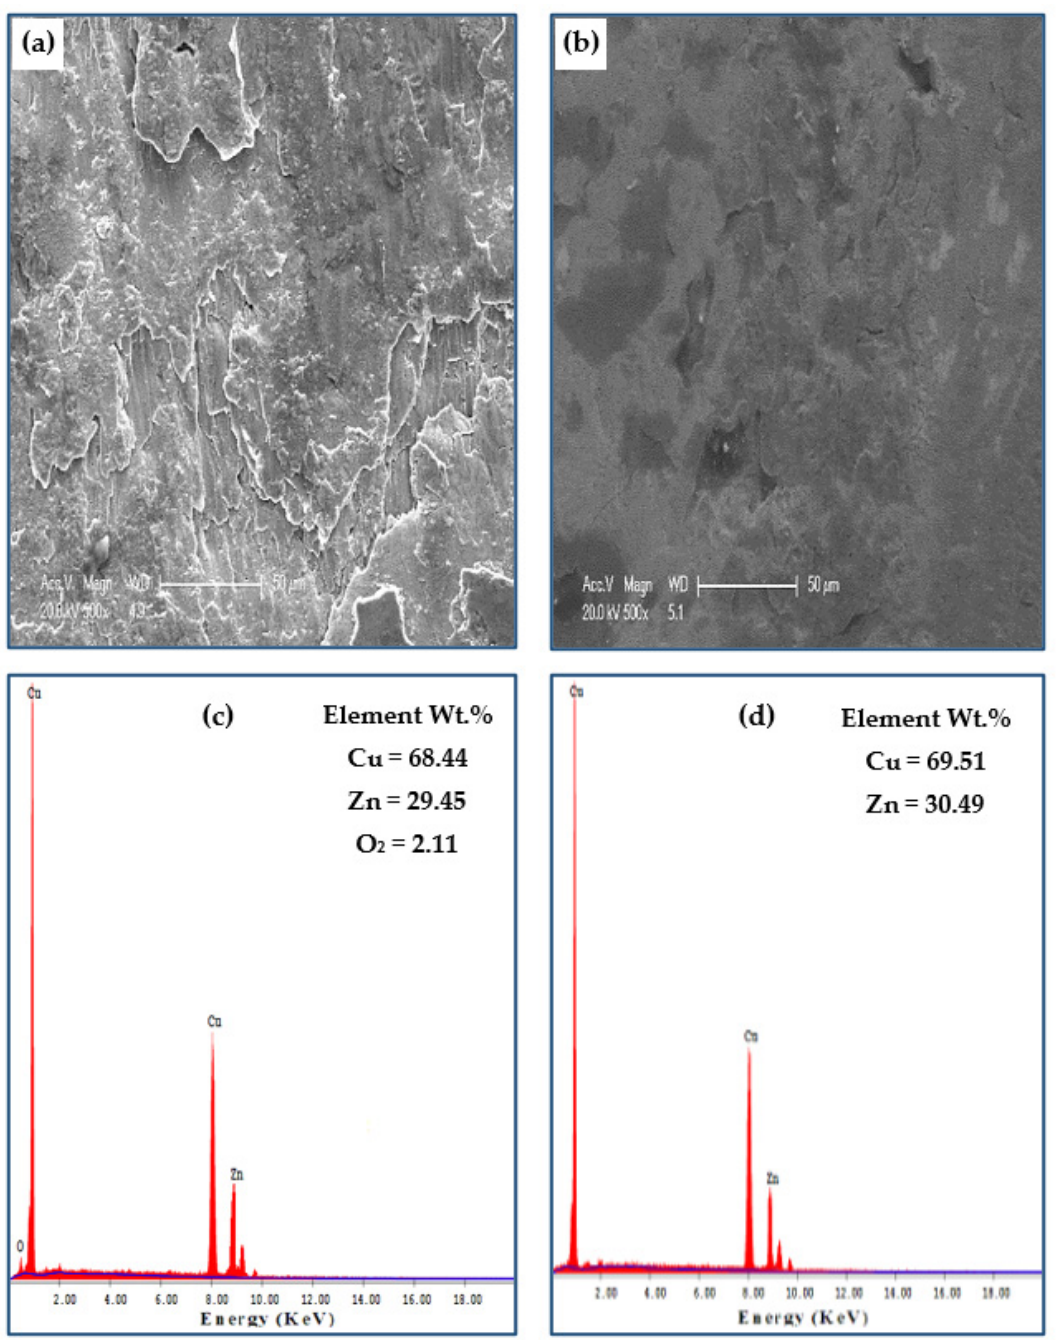
Figure 13. Worn surface morphology and EDS, analysis of brass tubes: ( a ) annealed, ( b ) 1 pass, ( c ) 2 passes, and ( d ) 4 passes, under a sliding distance of 1375.2 m and an applied load of 50 N.